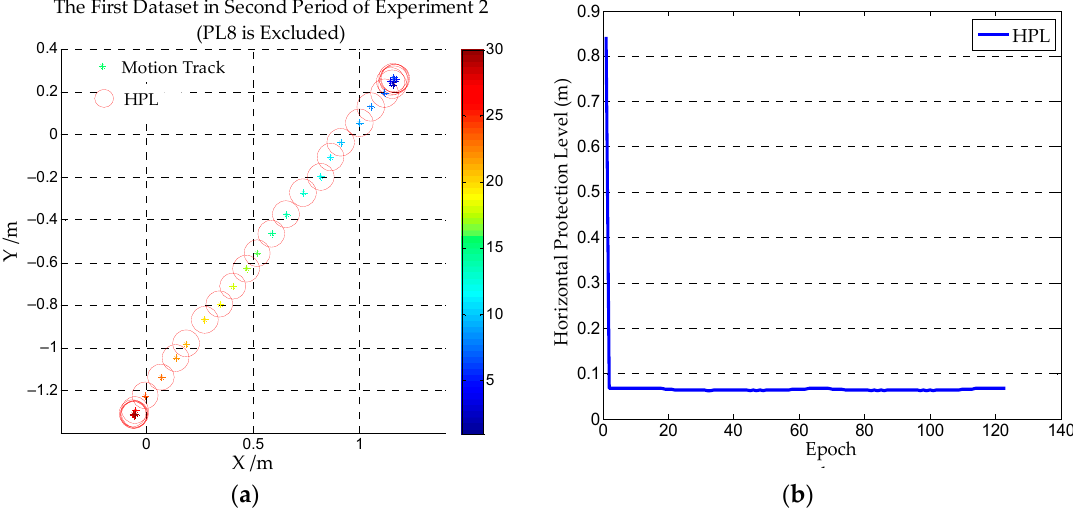
Figure 17. ( a ) The First Dataset in the Second Period of Experiment 2, ( b ) Horizontal protection level (HPL) of Experiment 2.